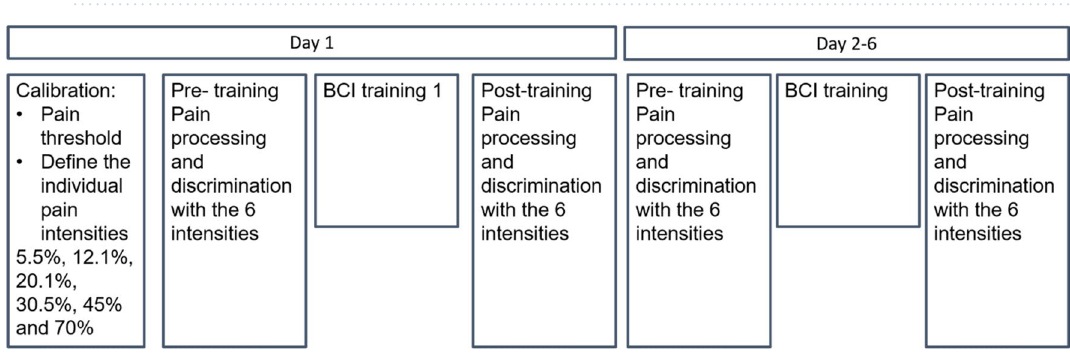
Figure 6. The hierarchical tree of analysis plugins used for the online feedback during the training. As a feedback signal the absolute success measure was presented to the participants as a number on the screen. This signal was identical in both groups and did not indicate whether a participants belonged to the up- or down- group. Therefore, the procedure was blinded to the participants as well as to the instructor. The Feedback display as shown for the participants also included information about the last ten seconds of success as color-coded circles around the feedback value (green circles representing positive success).